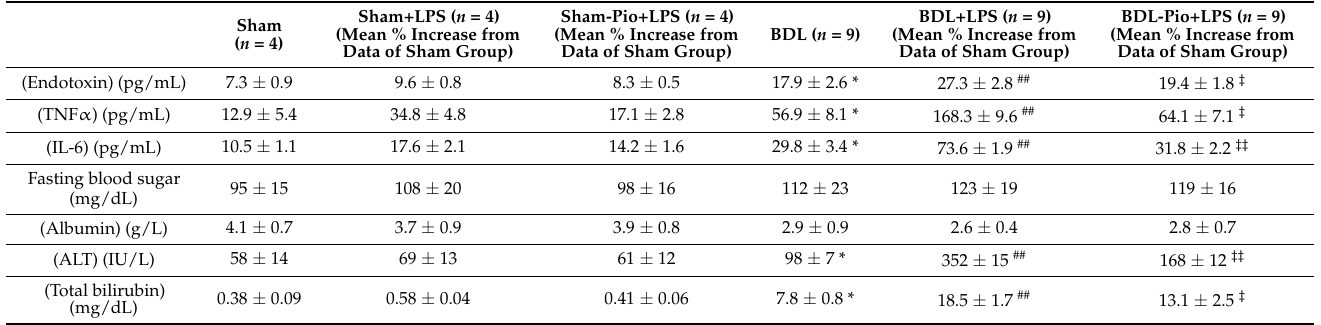
Table 3. Clinical and serum biochemical data of rats with biliary cirrhosis receiving pioglitazone or vehicle.